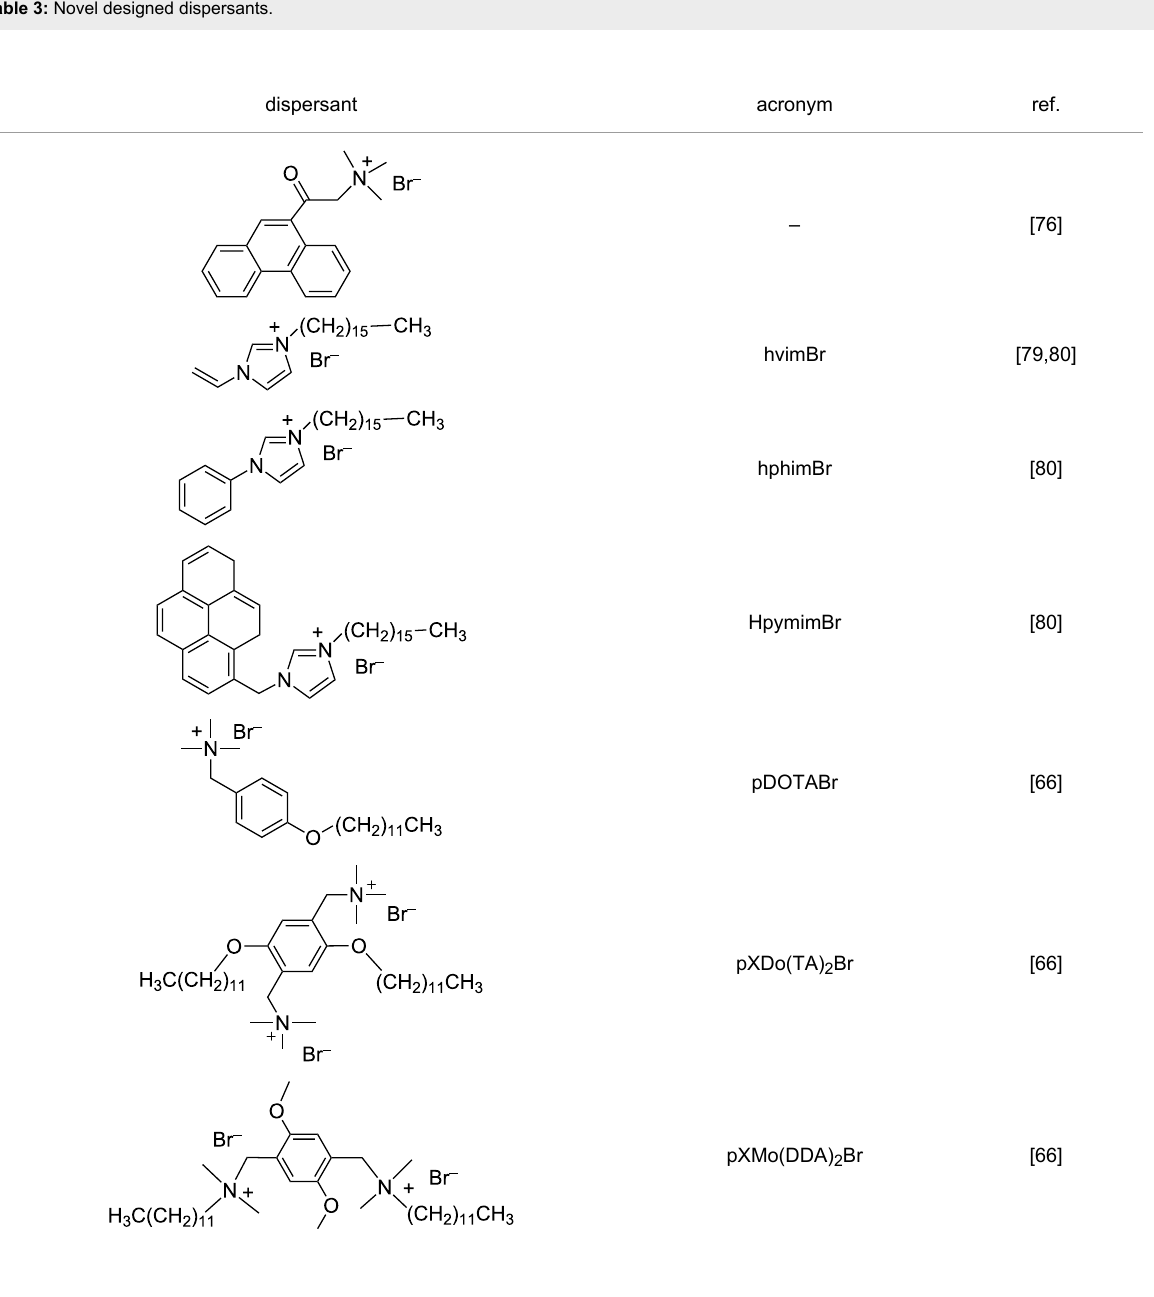
Table 3: Novel designed